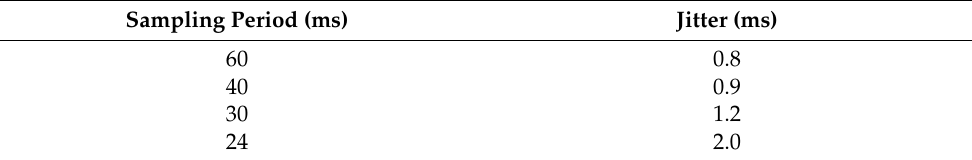
Table 6. Jitter for the measuring instant at multiple sampling operations.